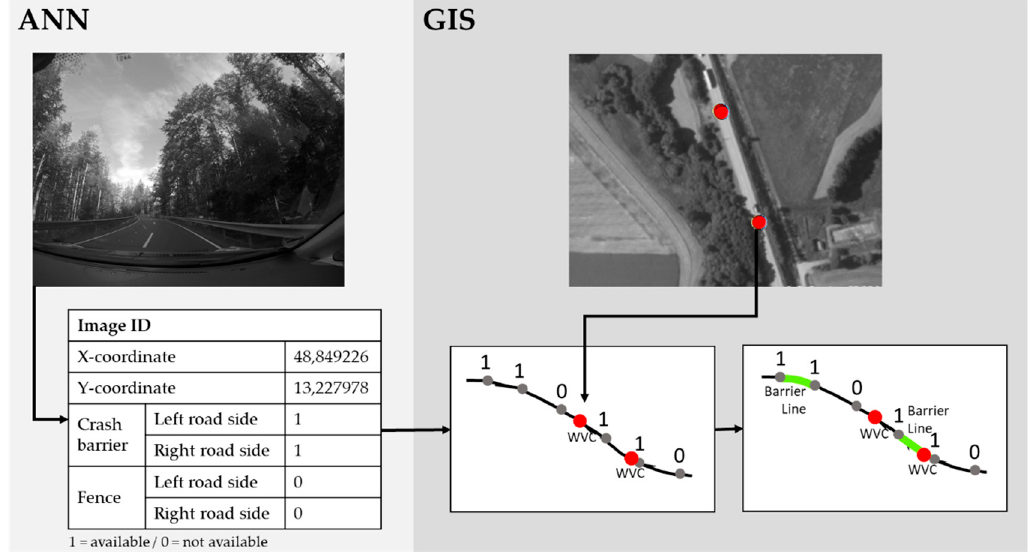
Figure 2. Concept of the intersecting process for barriers and WVC.